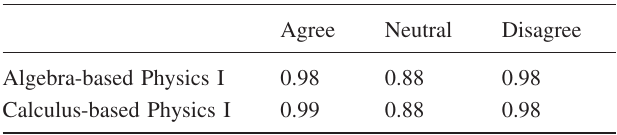
TABLE VI. Test-retest reliability fall 2004 to spring 2005, LSRU, CLASS V.3.